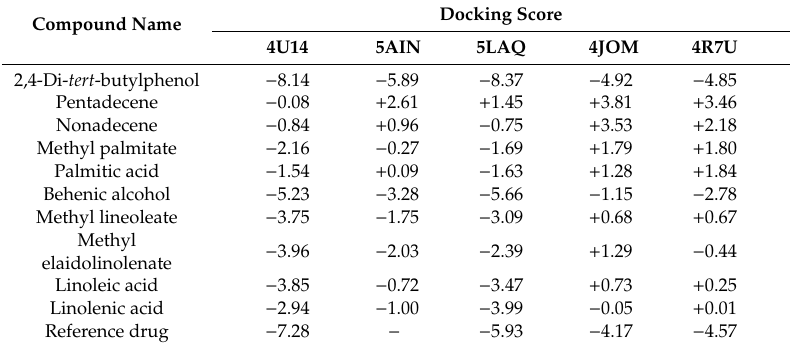
Table 6. Docking scores of the bioactive compounds identified in the dichloromethane extract (DTL) of T. leucostaphylum .